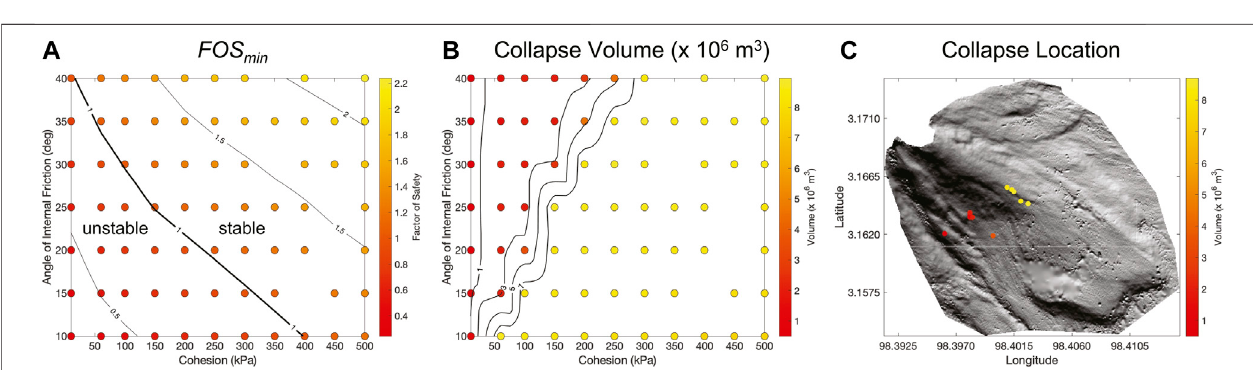
FIGURE9| Sensitivityofmodelresultstomaterialpropertiesinput.Bothcohesionandtheangleofinternalfrictionstronglyaffectthe FOS min forthe2014Sinabung DEM (A) . Contours in (A) show the FOS trend over the range ofmaterial properties.Each dot represents arun ofScoops3D, and the color corresponds to the FOS . The approximately diagonal orientation of the contours shows the two parameters have roughly equal impact on the FOS . The same plot is shown for the volume of the FOS min surface in (B) and shows that volume varies by an order of magnitude over the range of input parameters. The more vertically oriented tightly spaced contoursindicateagreaterin fl uenceofanarrowrangeofcohesionvalues(~50 – 250 kPa)onthevolumecomparedtotheangleofinternalfriction.Thelocationoftheaxis of rotation for each unstable ( FOS < 1) FOS min failure is plotted in (C) and colored by the volume. This shows that, for an unstable potential failure of a given volume, the location of the collapse is not very sensitive to the input material properties.